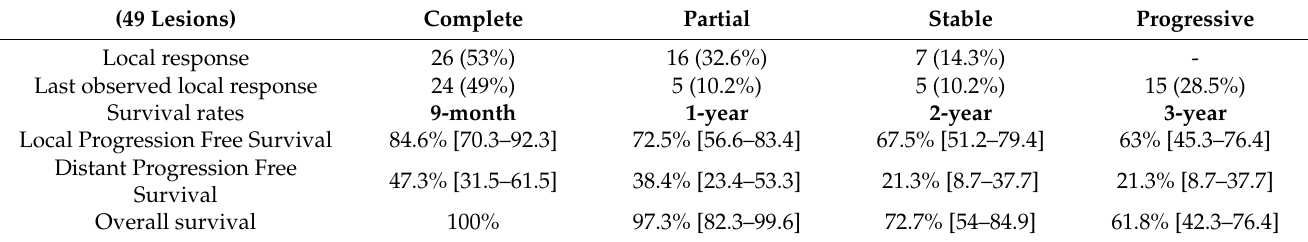
Table 2. Observed response evaluation to treatment and Kaplan-Meier estimates of survival [Confidence Interval 95%]. (49